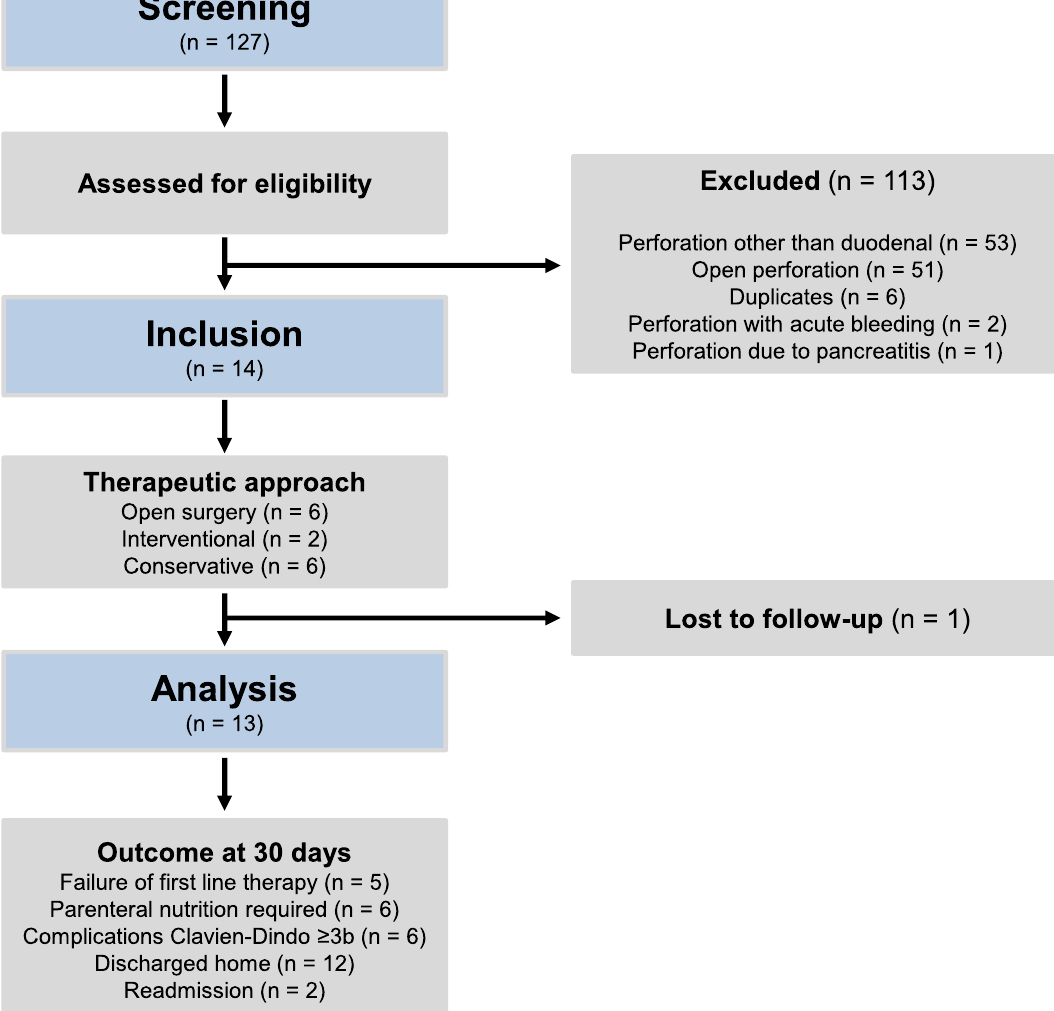
Figure 1. Screening, therapy decision, follow-up and analysis of patients. n